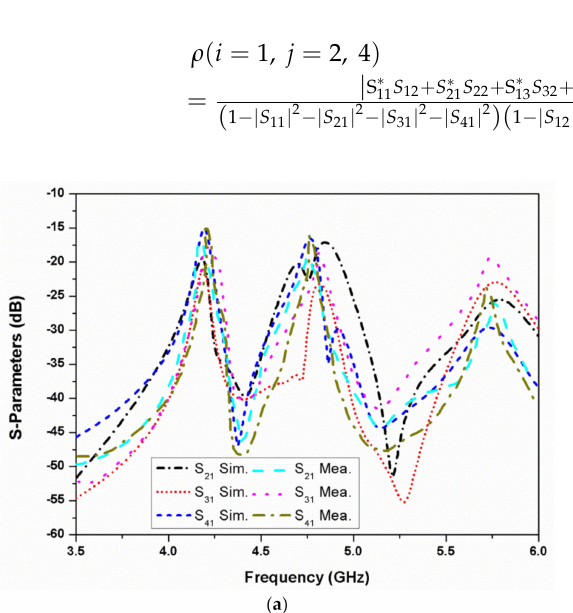
Figure 10. Simulated and measured reflection coefficients of the four-element stacked MIMO antenna.